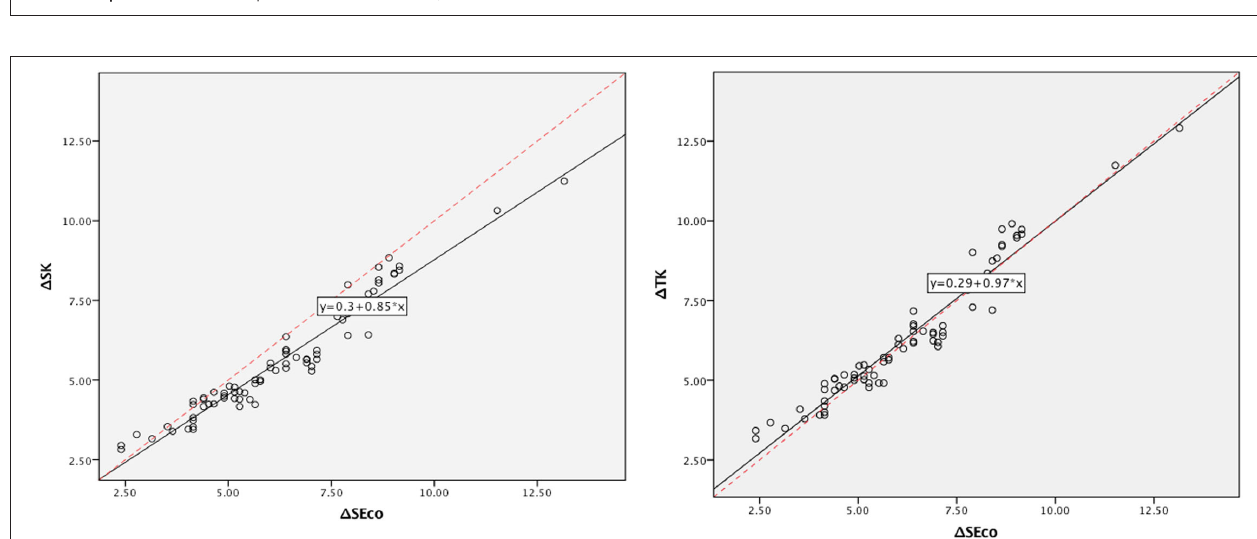
FIGURE 2 | The Bland Altman plot of 1 SEco and 1 SK, and 1 SEco and 1 TK.